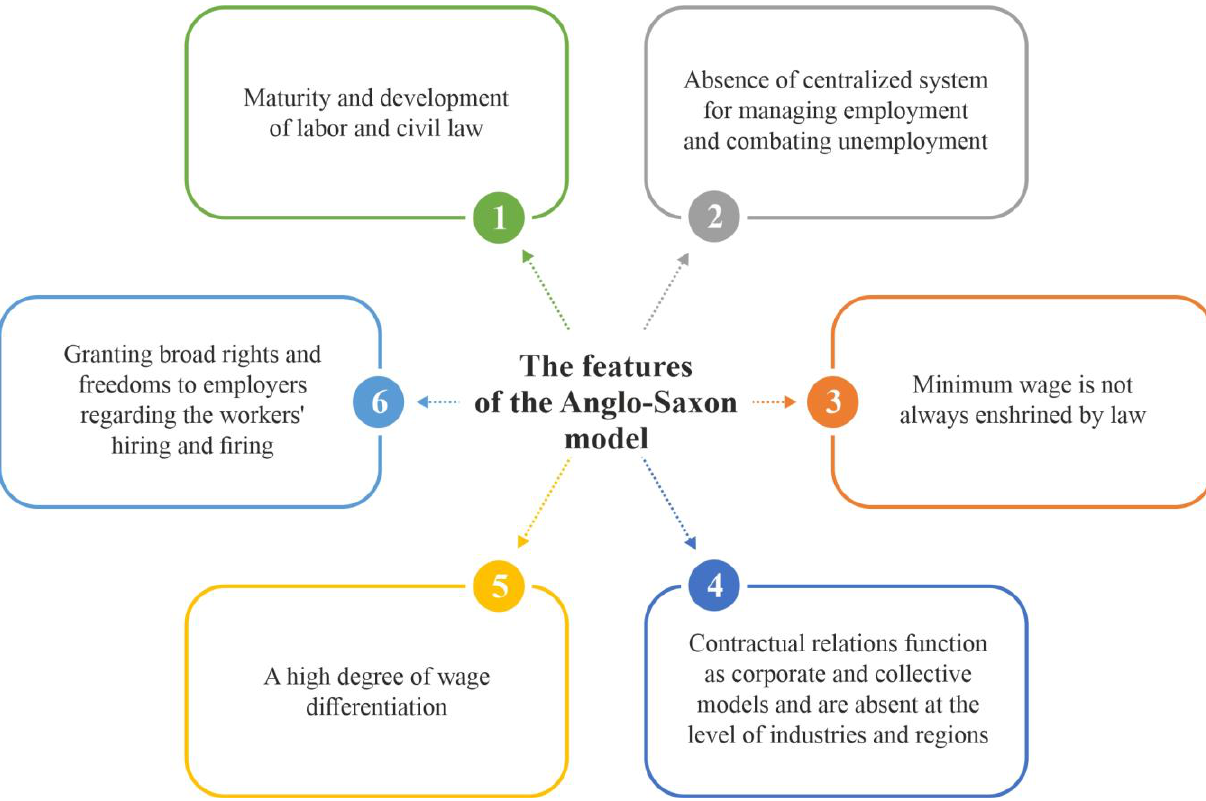
Figure 1. Features of the Anglo-Saxon model of social and labor